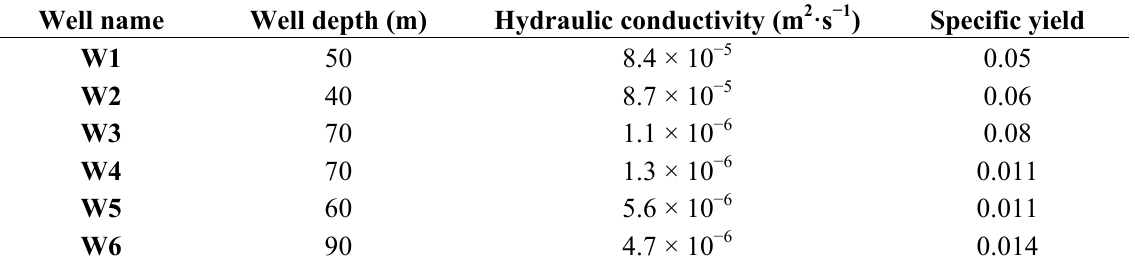
Table 2. Hydraulic conductivity and specific storage of different regions of the aquifer. Well name